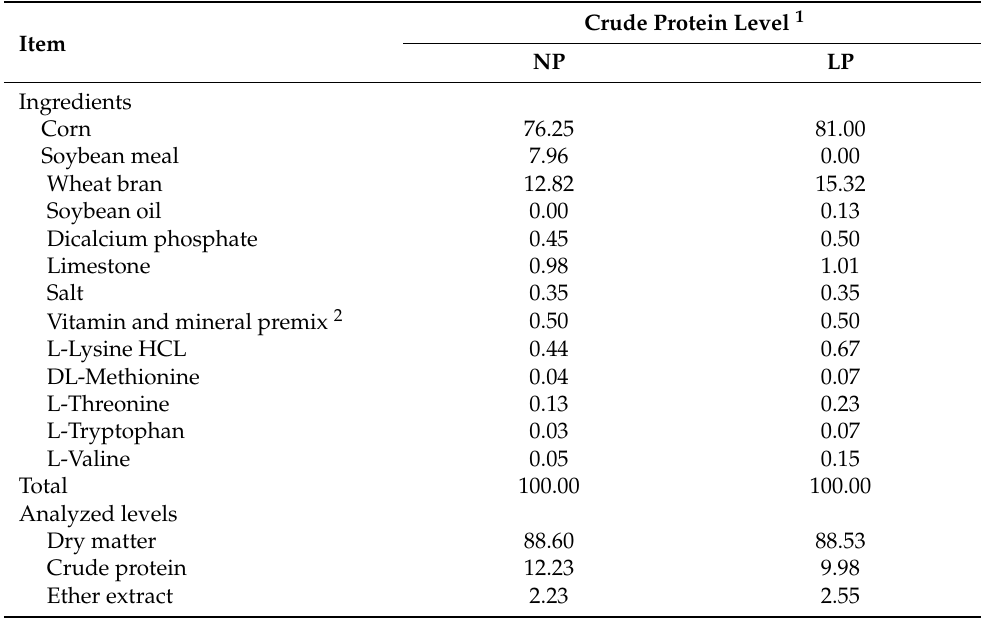
Table 1. Ingredient composition of the experimental diets (%, as-fed